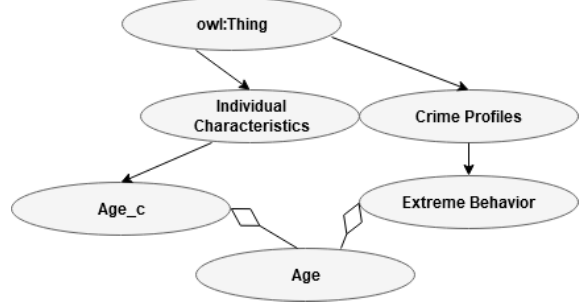
Figure 9. Relationship between age (I) and age (CP).